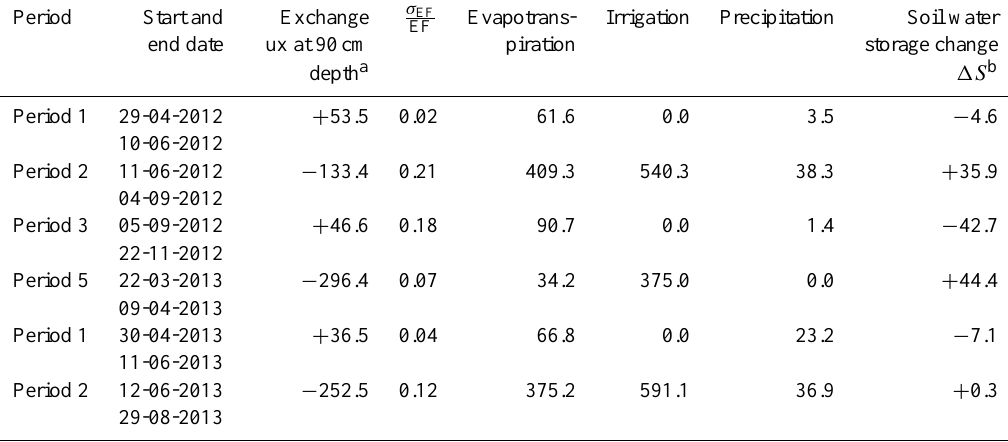
Table 2. The water balance in the control volume (unit: mm). Period Start and Exchange σ EF Evapotrans- Irrigation Precipitation Soil water EF end date flux at 90cm piration storage change depth a 1S b Period 1 29-04-2012 + 53.5 0.02